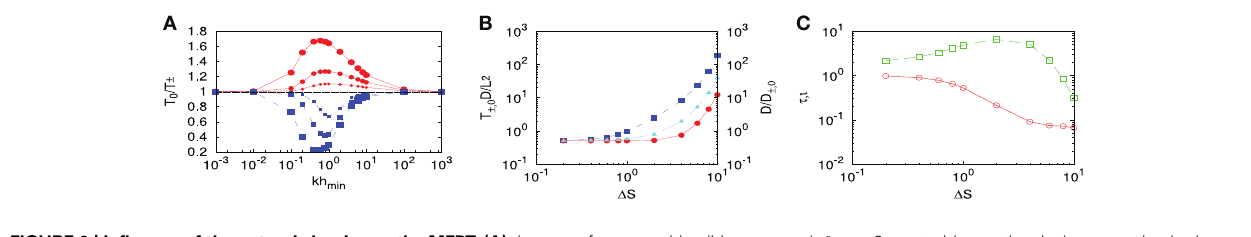
positive (blue squares), β q ζ = 3, neutral (cyan triangles), or negative (red dots), β q ζ = − 3, tracers in a conducting channel being kh min = 1 for all points in the figure. (C) ratio of the MFPTs (red circles), τ = T − / T + , and “current” | ρ + T − − ρ − T + | (green squares), i = 2 L 3 σ D T − T + being T ± the MFPT of positive (negative) tracers and σ the charge density on the channel walls as a function of the entropic barrier (cid:3) S for the same parameters as in (B)